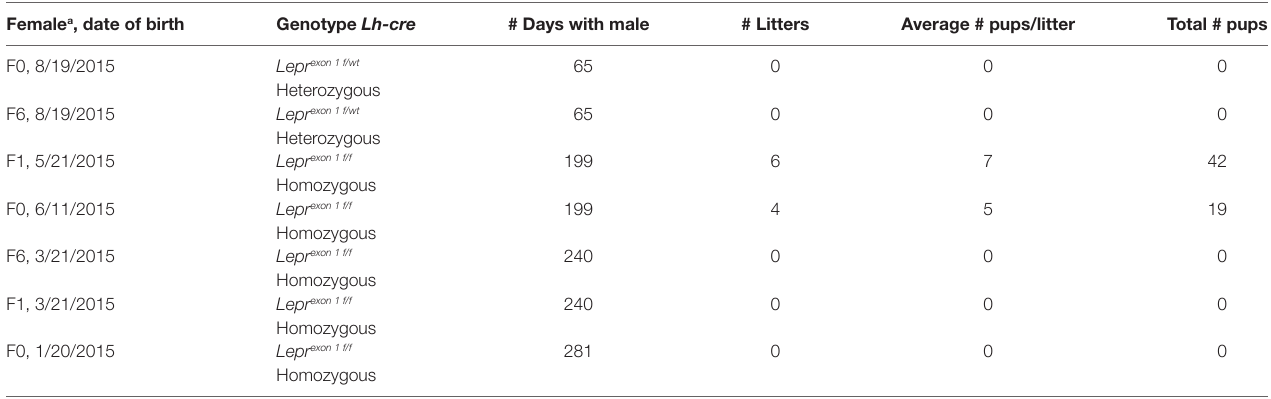
taBLe 1 | Deleting all isoforms of leptin receptor (LEPR) in gonadotropes causes